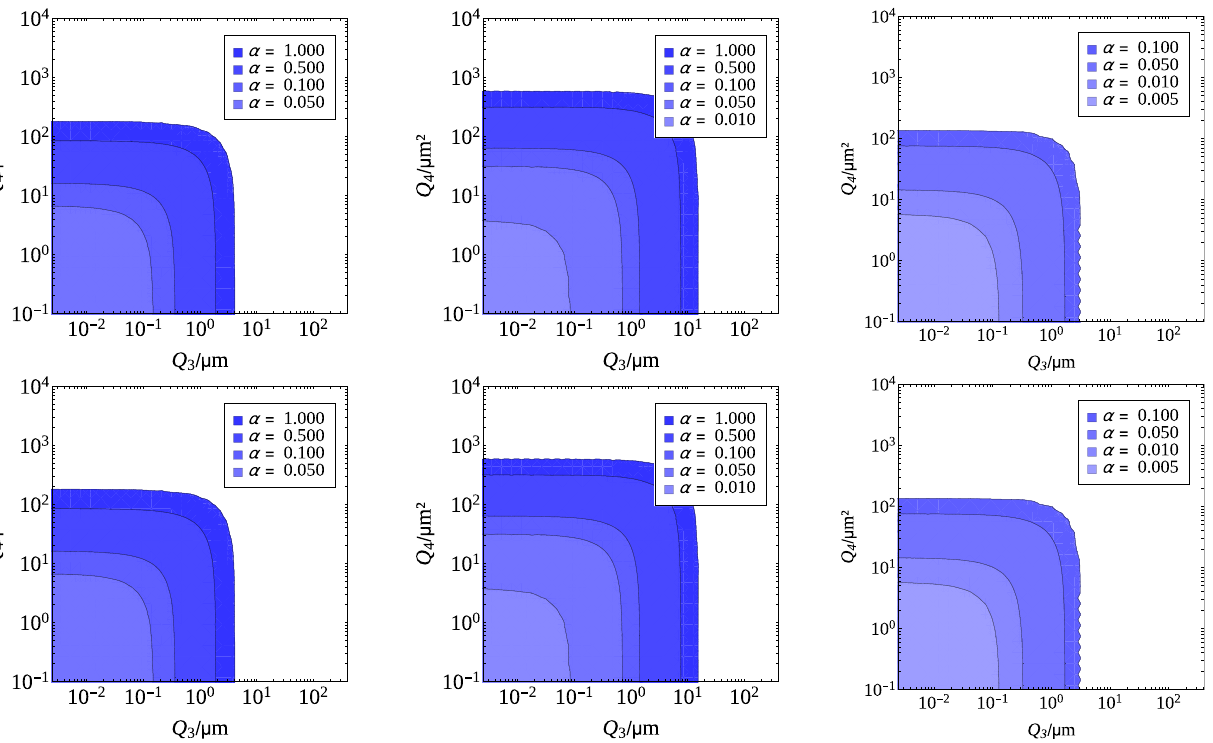
Fig. 12 Values of background sources Q 3 and Q 4 (blue shaded regions) for which the precession induced by the mN-potential differs from that induced by the BN-potential, for specific points in the ( λ,α ) plane, by a value larger than twice the clock precision (2 s). Within this region we could claim that any observed precession would be due to